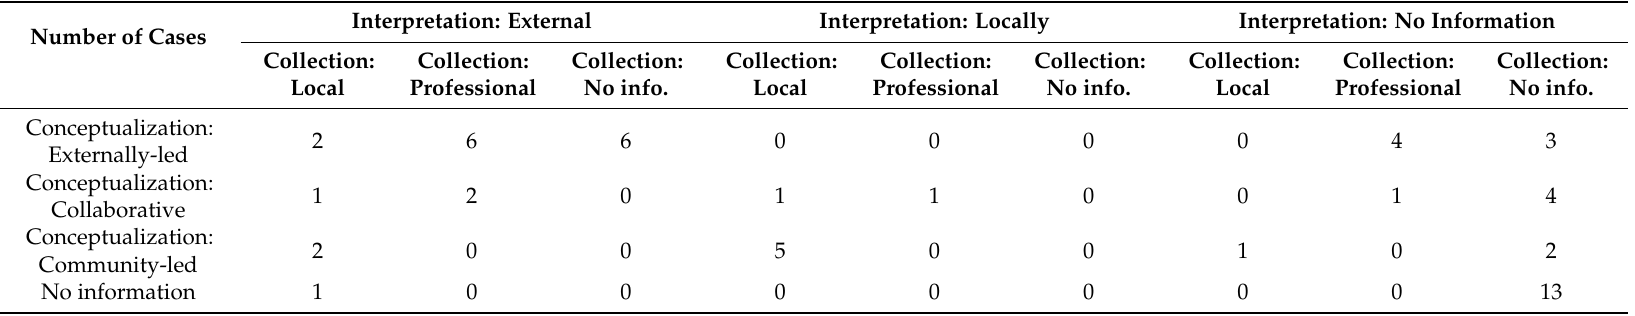
Table 2. Summary of partial classification using the three features of the proposed classification model: conceptualization (first column), collection (second row) and interpretation (first